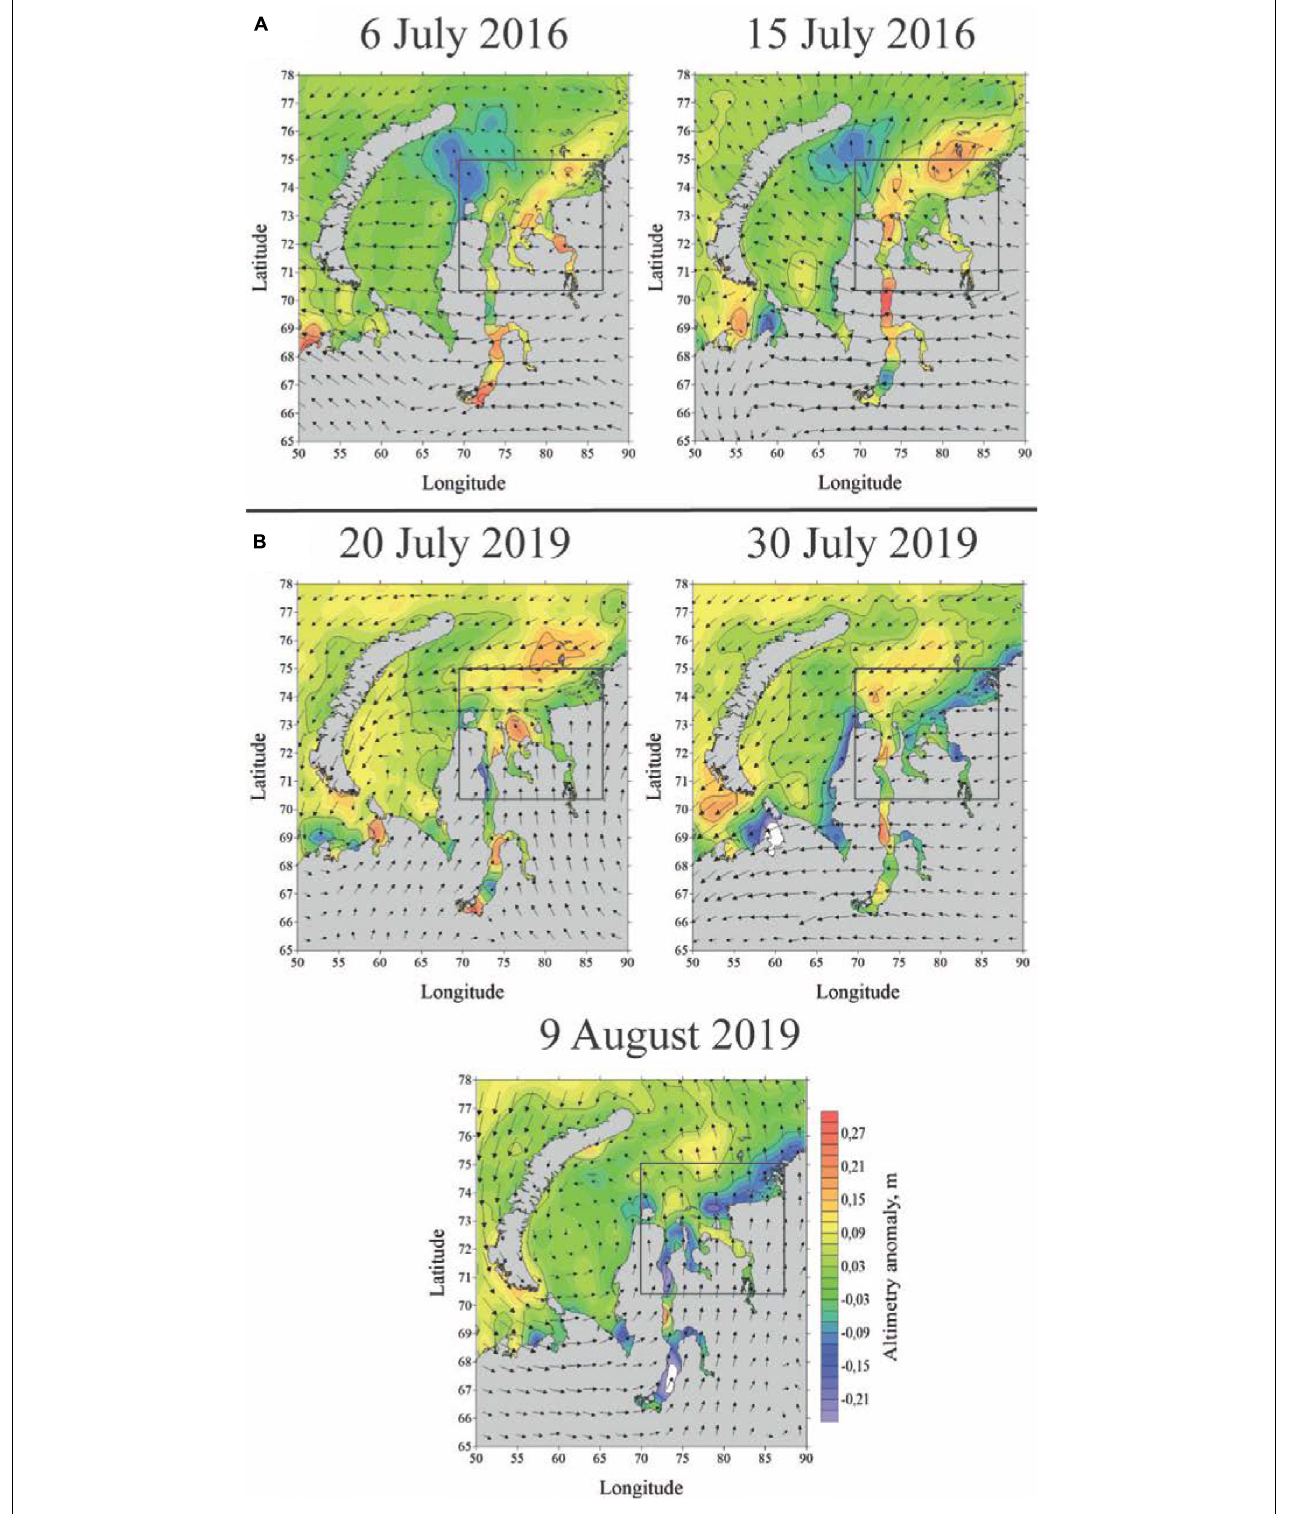
FIGURE 8 | AVISO satellite altimetry anomaly in the Kara Sea on July 6 and July 15, 2016 (A) , on July 20, July 30, and August 9, 2019 (B) . Black arrows indicate wind direction. Black rectangles indicate the location of area as shown in Figure 9 .